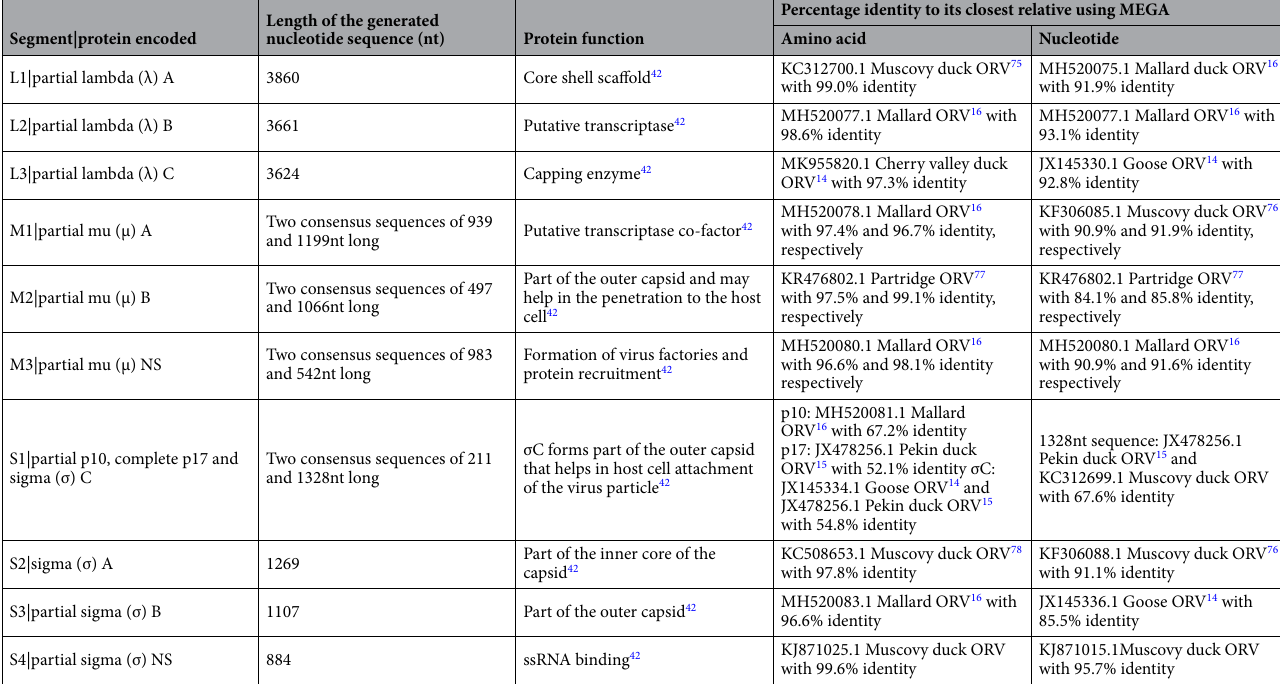
Table 2. Details on the avian orthoreovirus from Pacific black duck 08.18 sample